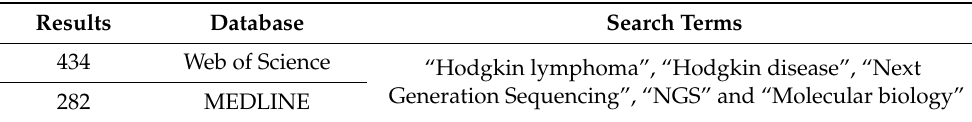
Table 1. Search strategies and results for each